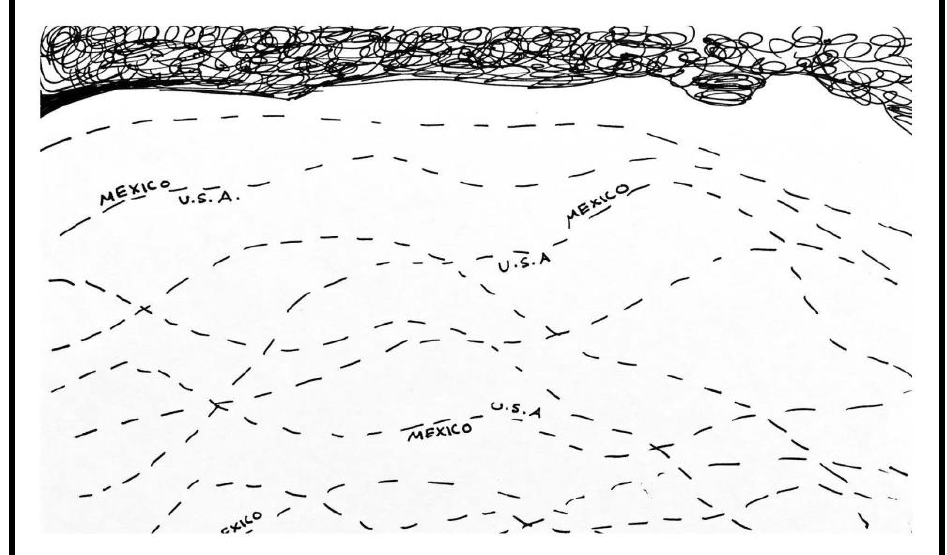
Detail from J.M. Design Studio, “Prototype #3 A Wall of Artists Redrawing Borders” from The Other Border Wall Proposals (2017). Digital scanned image of ink drawing on paper, text. 8 ½ X 11 inches. Collection of J. M. Design